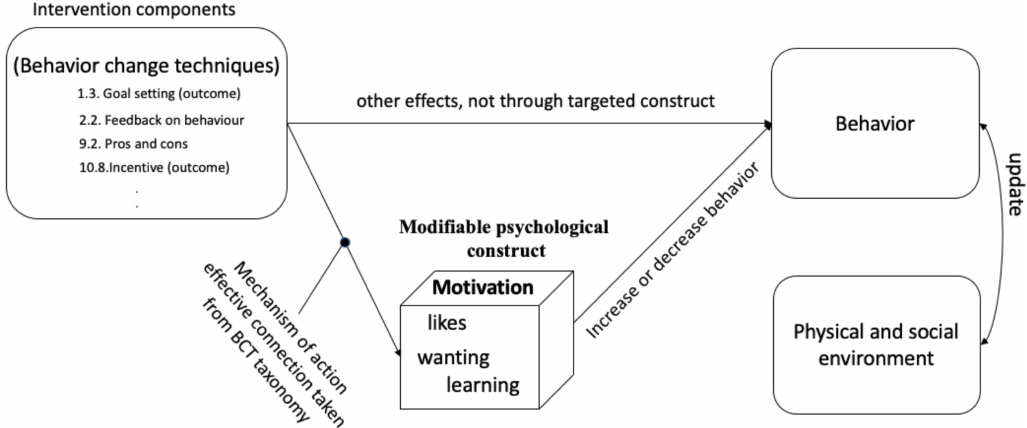
Figure 1. The model postulates the ‘motivation’ as the mechanism of action for a behavior change